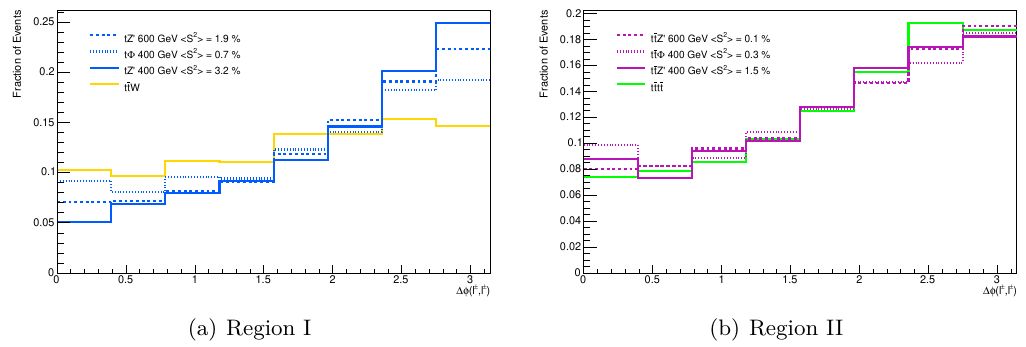
Figure 13 . Fraction of events of the azimuthal angular distance between the same-sign leptons for the main processes in Regions I and II. We find it useful to disentangle tZ 0 / Φ from t ¯ tW in Region I.